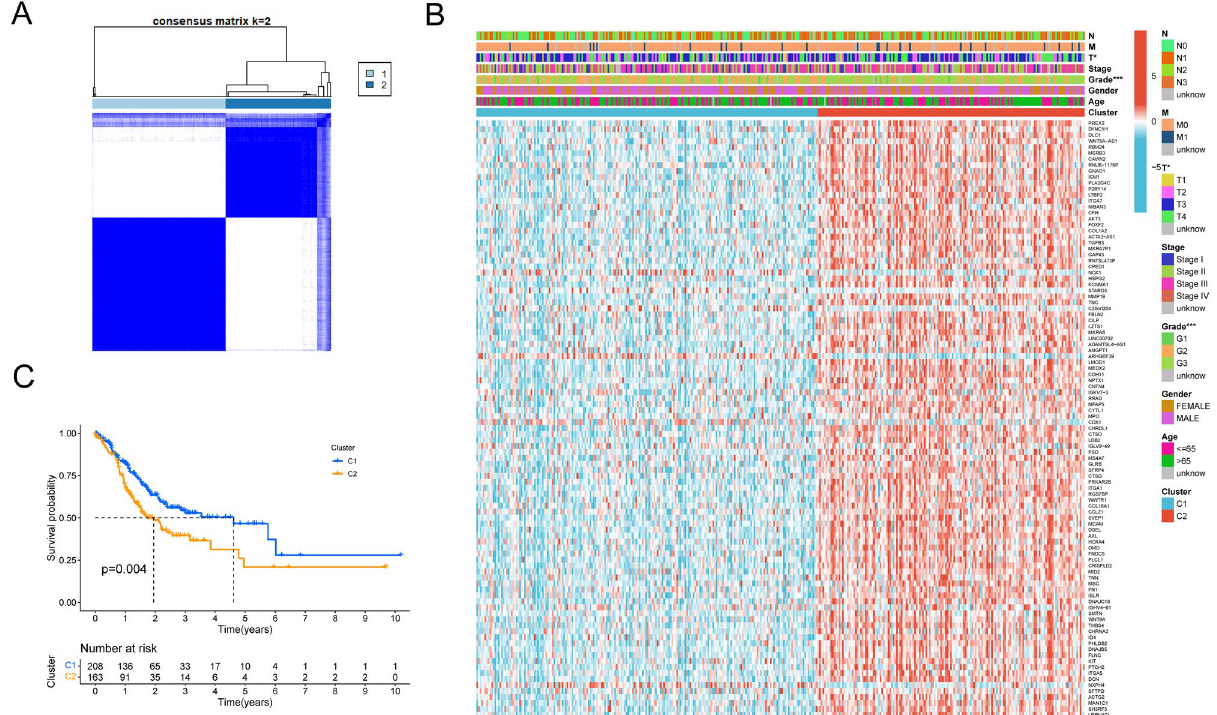
Figure 2. Tumor molecular subtypes related by differentially expressed necroptosis-related genes. ( A ) Consensus clustering of GC patients for k = 2 in the meta-cohort (TCGA-GC and GSE84437). ( B ) Unsupervised clustering heatmap of top 100 DEGs in GC. Clusters, age, gender, grade and stage were used as patient annotations. Red represents high DEGs expression and blue low DEGs expression. * p < 0.05; ** p < 0.01; *** p < 0.001. ( C ) Kaplan–Meier curves (Log-rank test, P = 0.004) for OS of two necroptosis-related molecular subtypes. Blue line represents cluster C1 (n = 208), yellow line represents cluster C2 (n = 163). DEGs, differentially expressed genes between various molecular subtypes; OS, overall